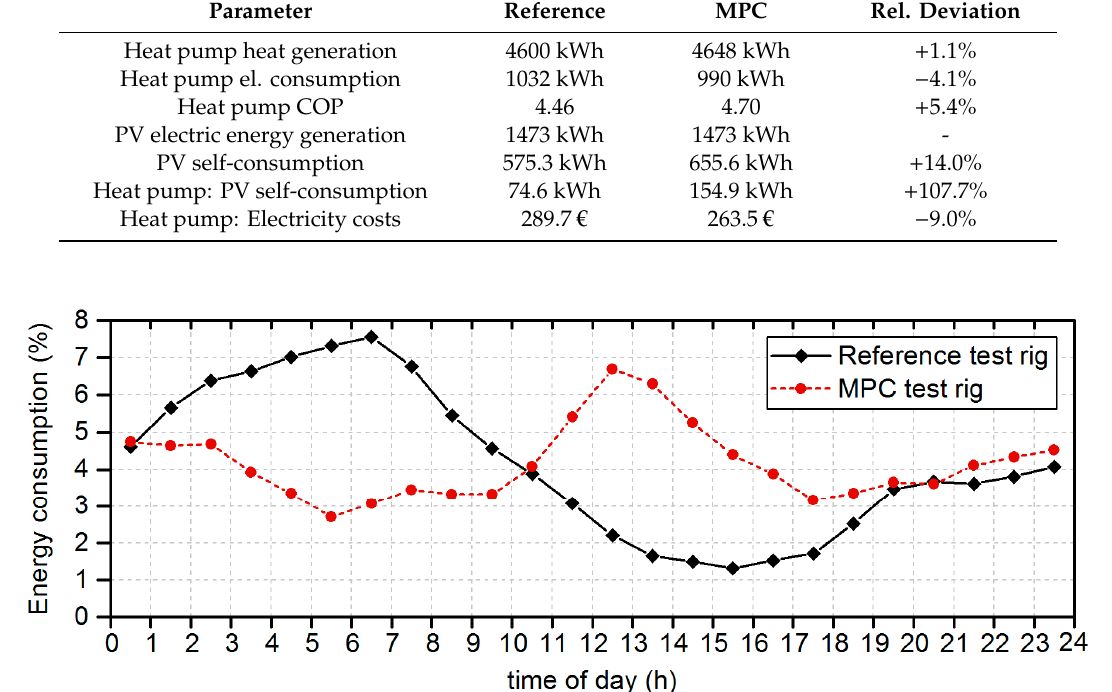
Figure 5. Hourly average values of the electrical energy consumption of the heat pumps.